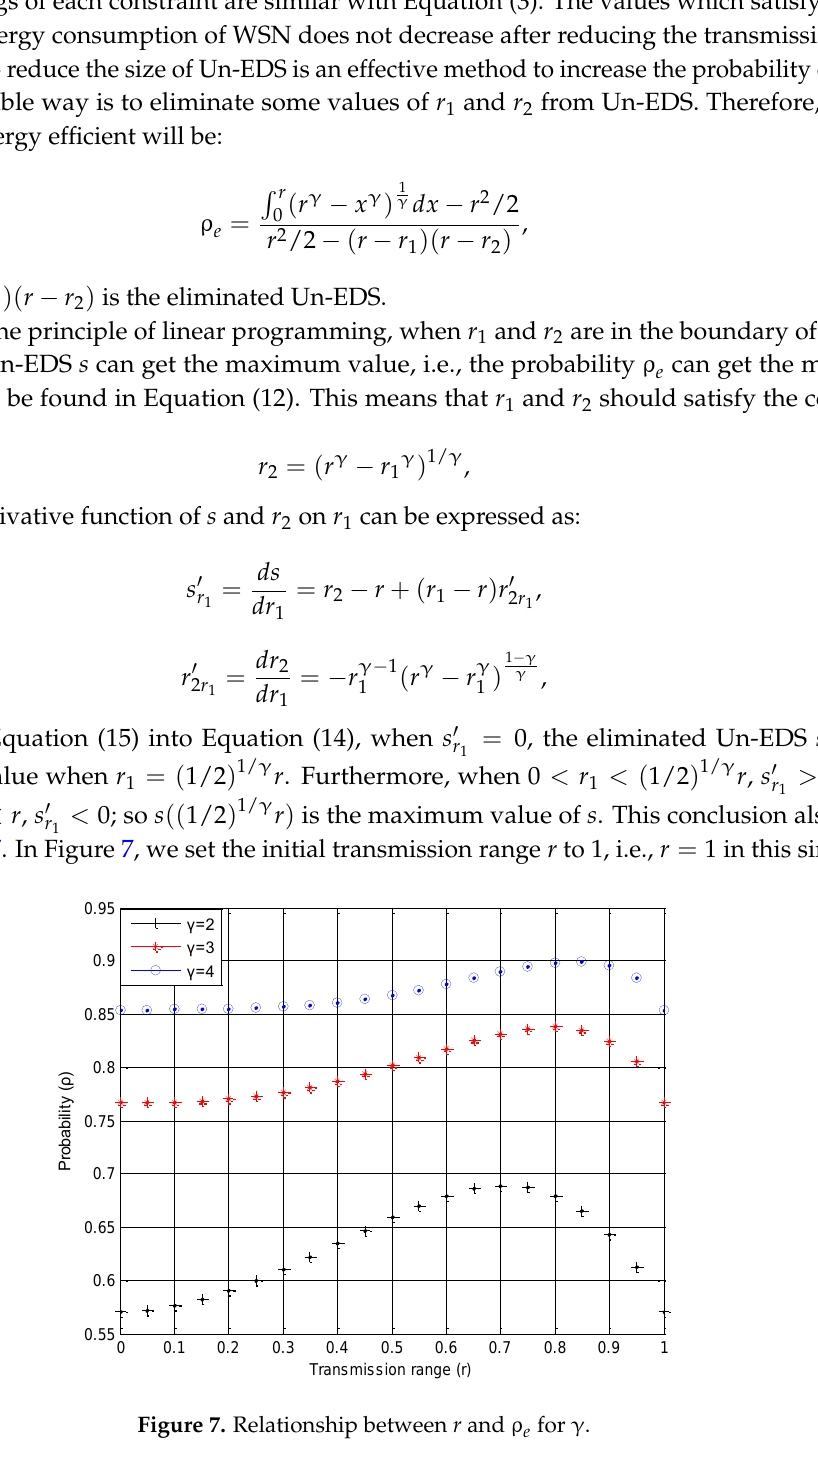
Figure 7. Relationship between r and ρ e for γ